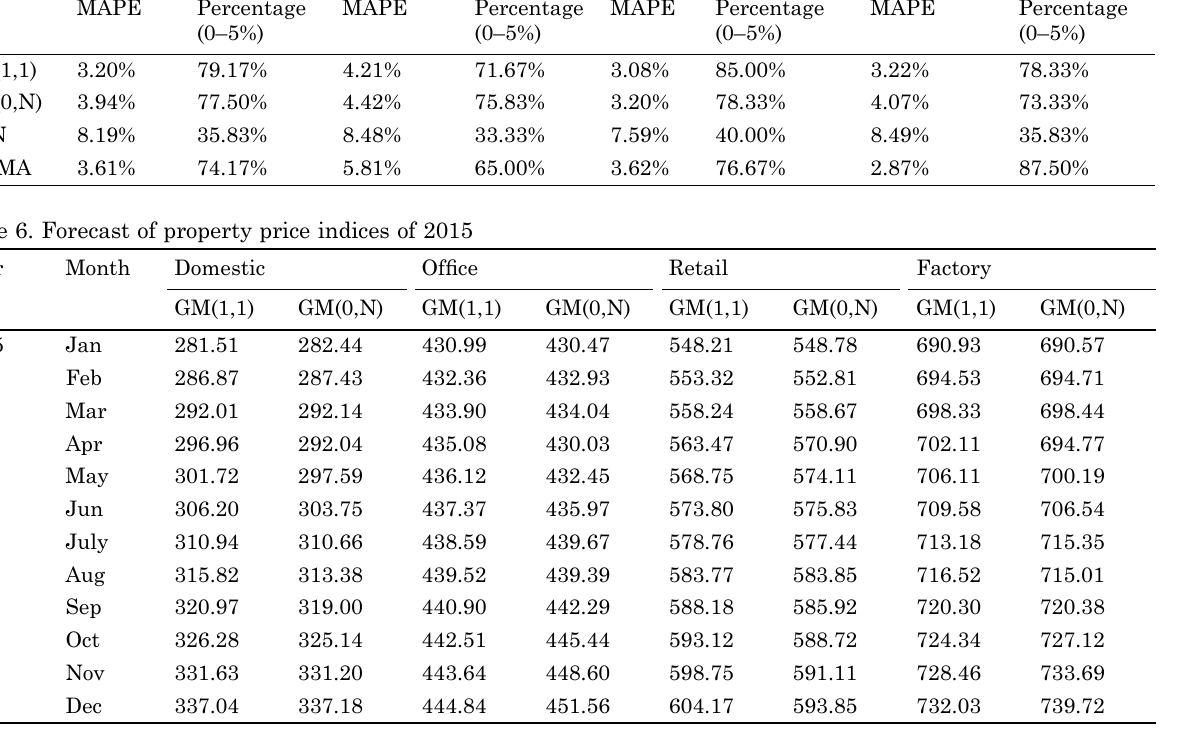
Table 5. Forecasting performance of four models (Jan 2005–Dec 2014) Model